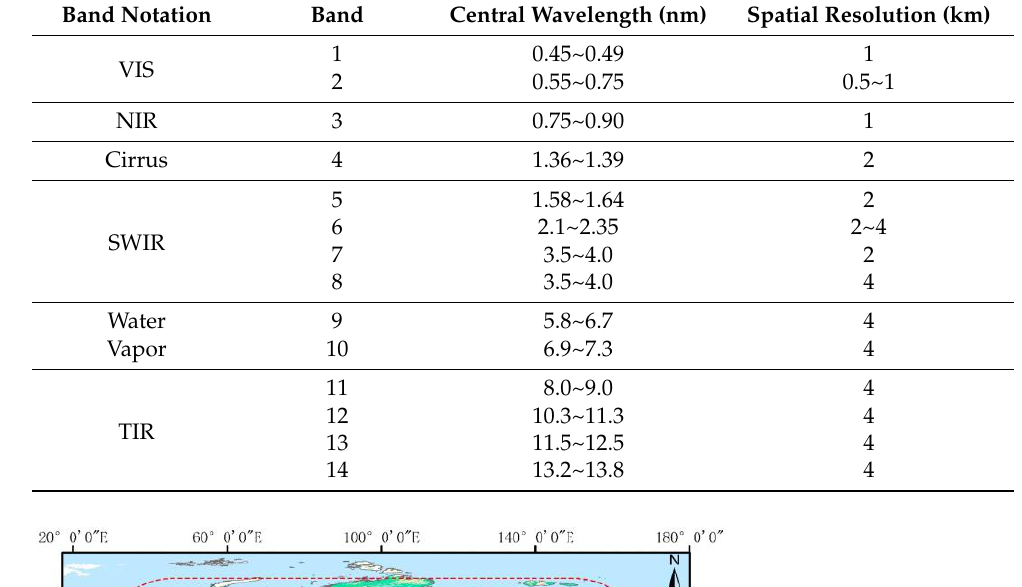
Table 1. FY-4A AGRI band characteristics.